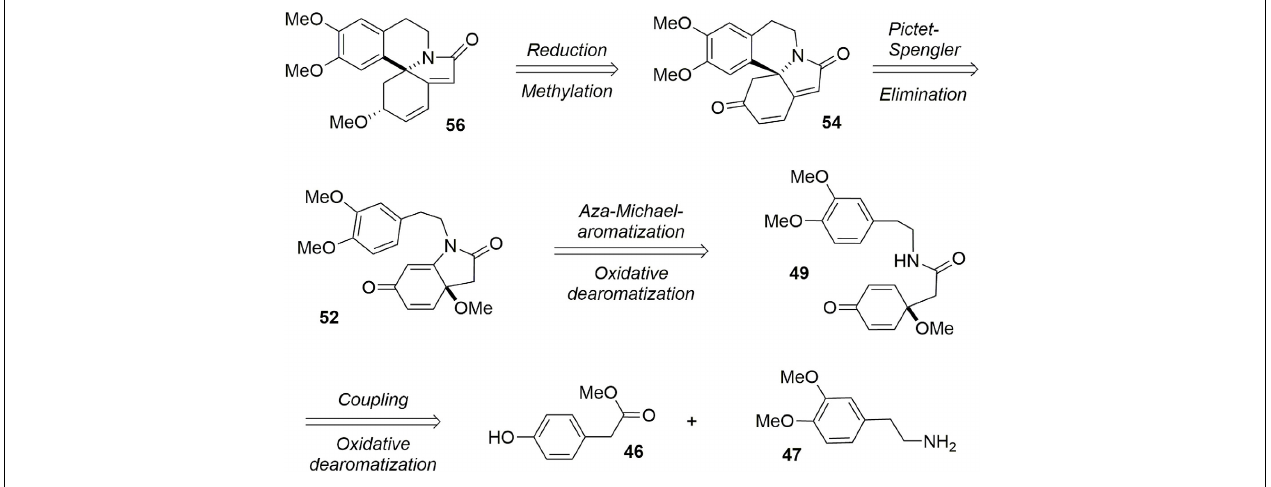
FIGURE 10 | Retrosynthesis of erysotramidine.